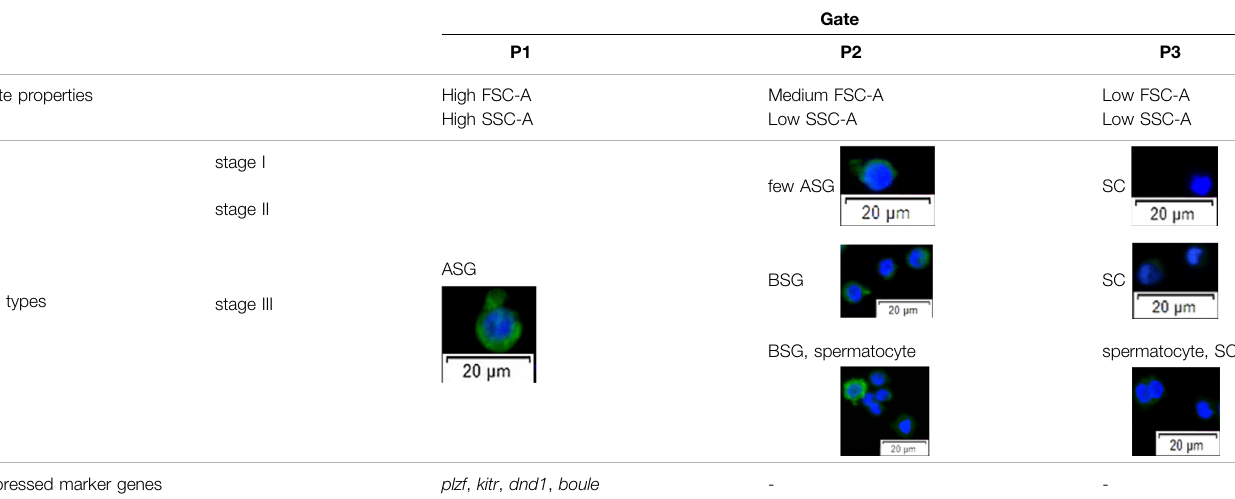
TABLE 2 | Summary of cell characteristics among sorting gates using fl ow